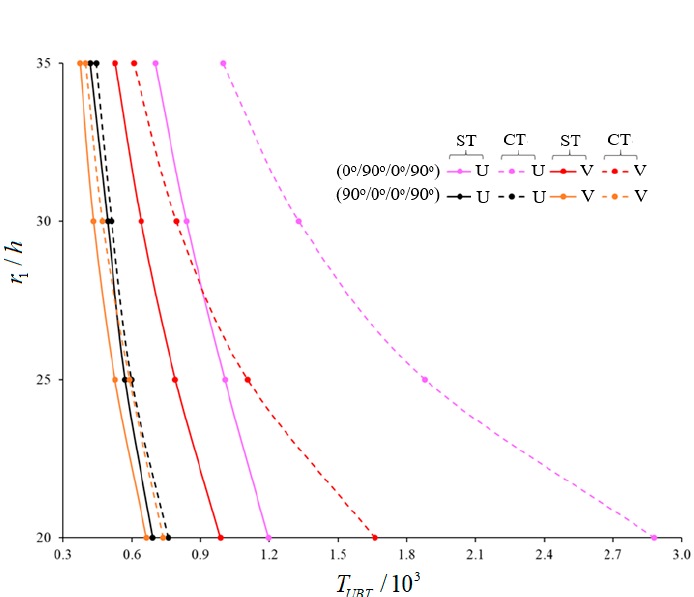
Figure 4. Variations of UBT for (90°/0°/90°) ‐ and (0°/90°/0°) ‐ array laminated cones with U ‐ and X ‐ shaped layers for Cos ‐ Hyp ‐ TSS function (within CT versus 1 / r h ).